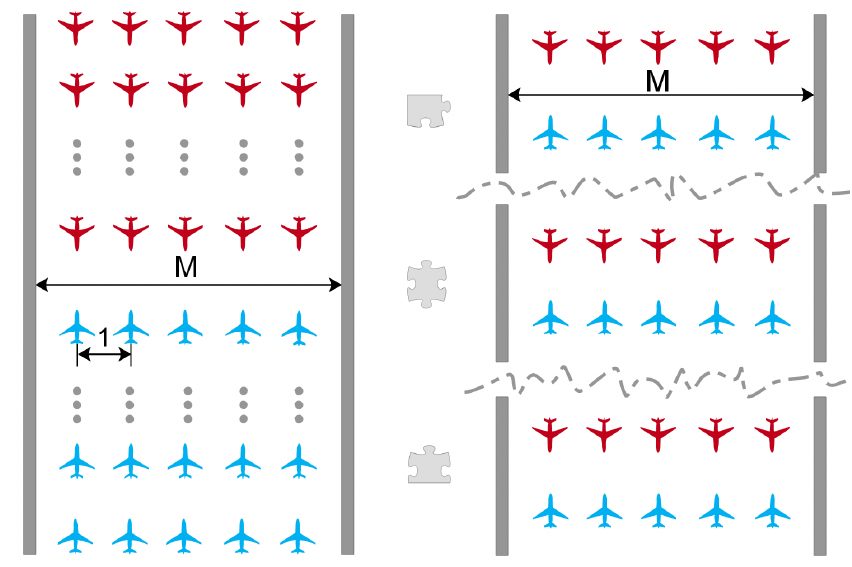
Figure 4. UAVs in swarms are evenly distributed to 3